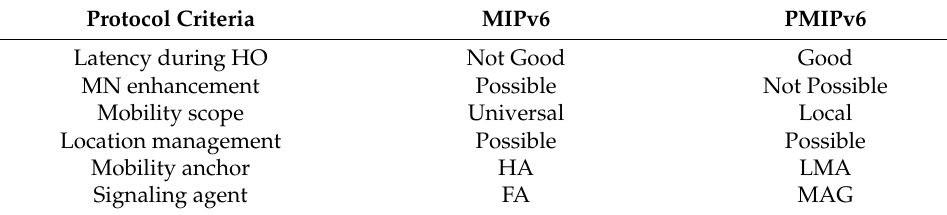
Table 1. Differences between MIPv6 and PMIPv6. Protocol